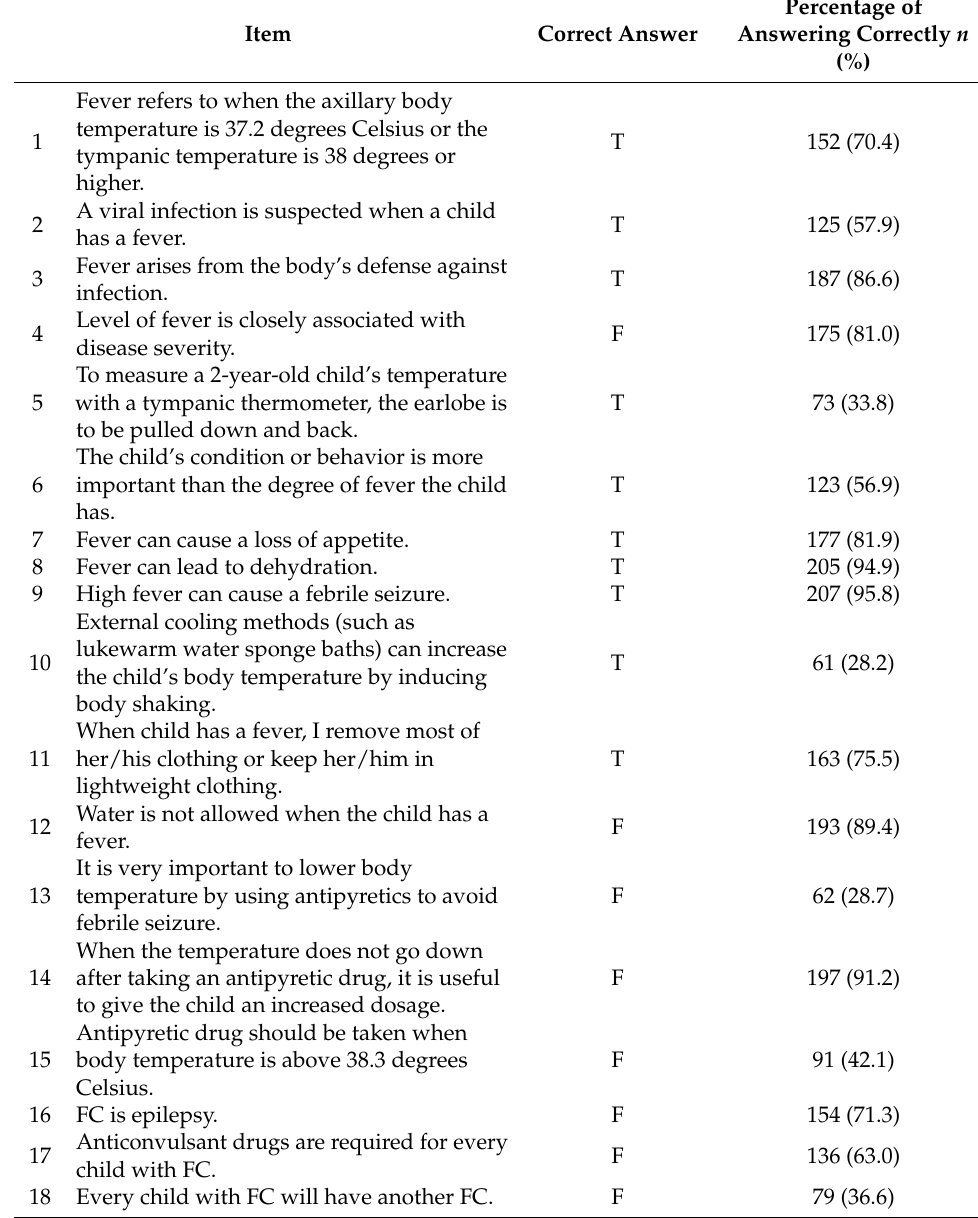
Table A1. Percentage of Childcare Providers Answering Correctly on Knowledge about FC